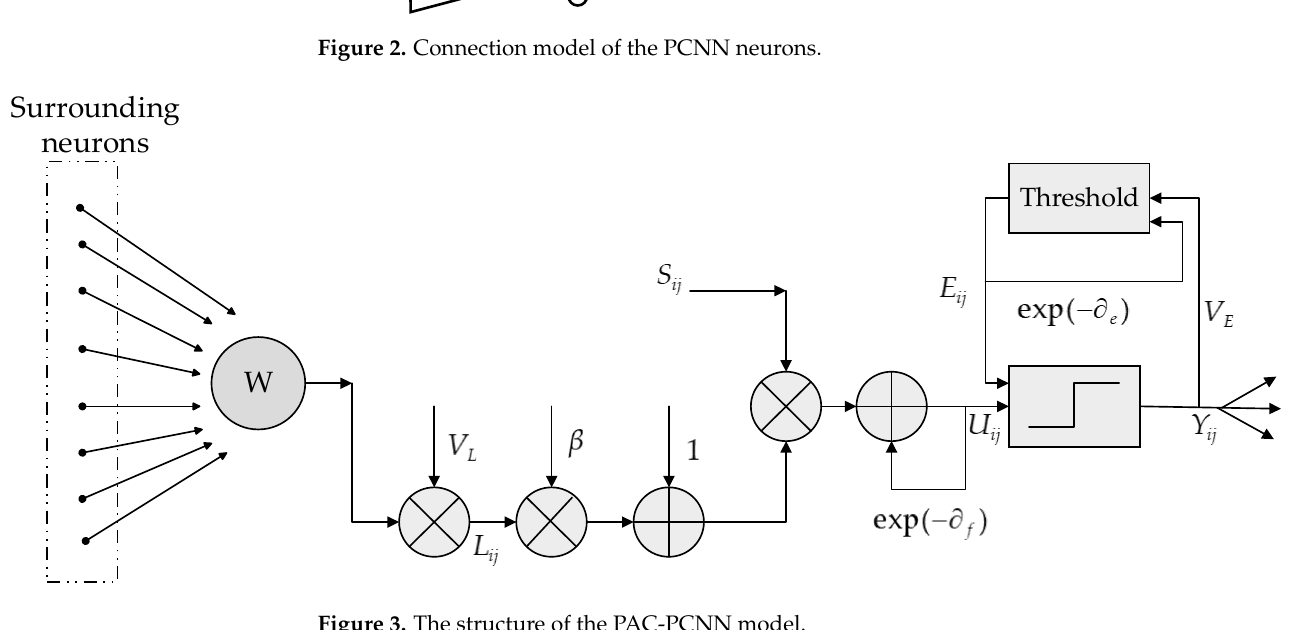
Figure 3. The structure of the PAC-PCNN model. In the above PAC-PCNN model,